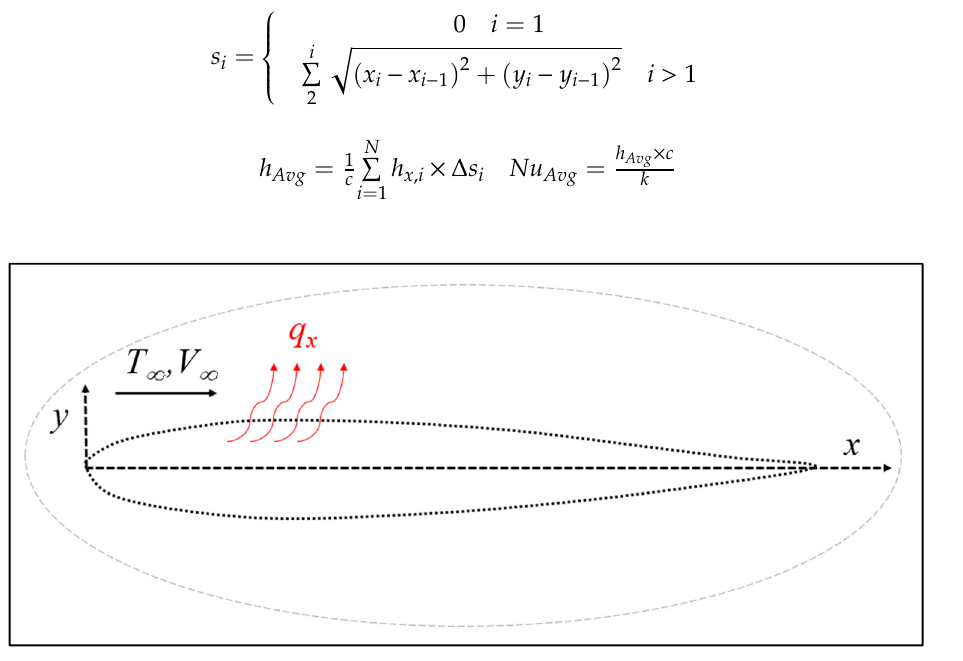
Figure 1. Freestream flow over a two-dimensional (2D) NACA 0012 airfoil.